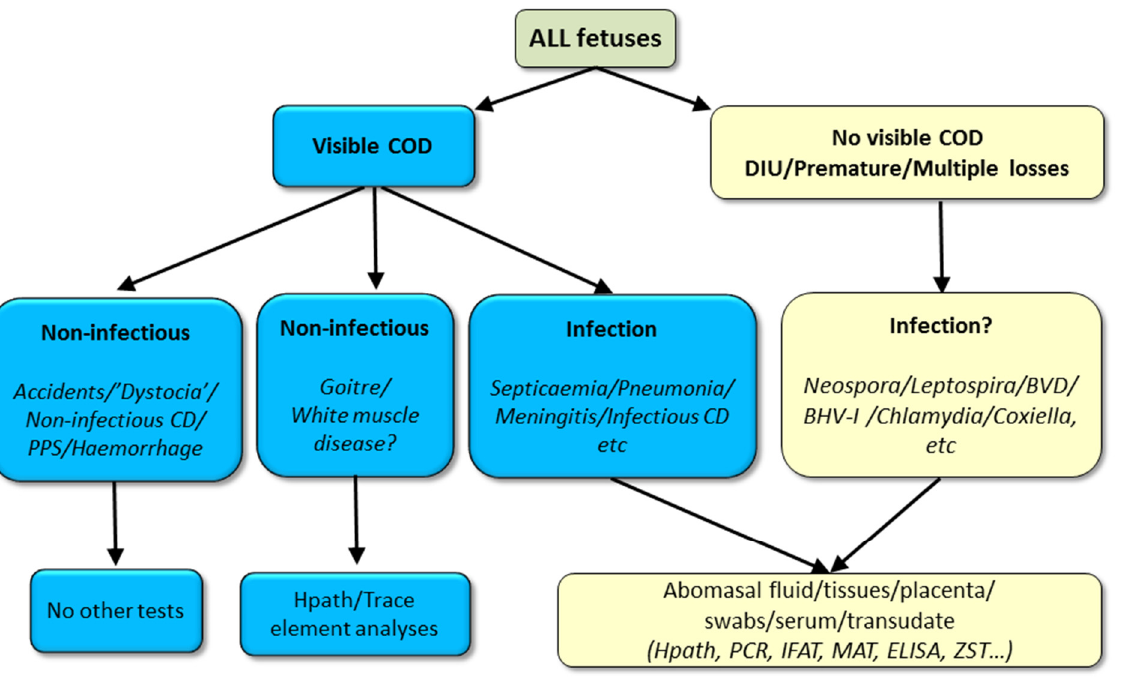
Figure 8. Necropsy sample selection decision tree for stillborn foetuses (COD = cause-of-death, CD = congenital defect, DIU = dead in utero). Footnote. While a non-infectious cause of death may be grossly suspected or apparent, occult infection may also be present, hence, where mandated by law or where infection is also suspected, sample/s should be collected to rule out infection, typically, abomasal contents .